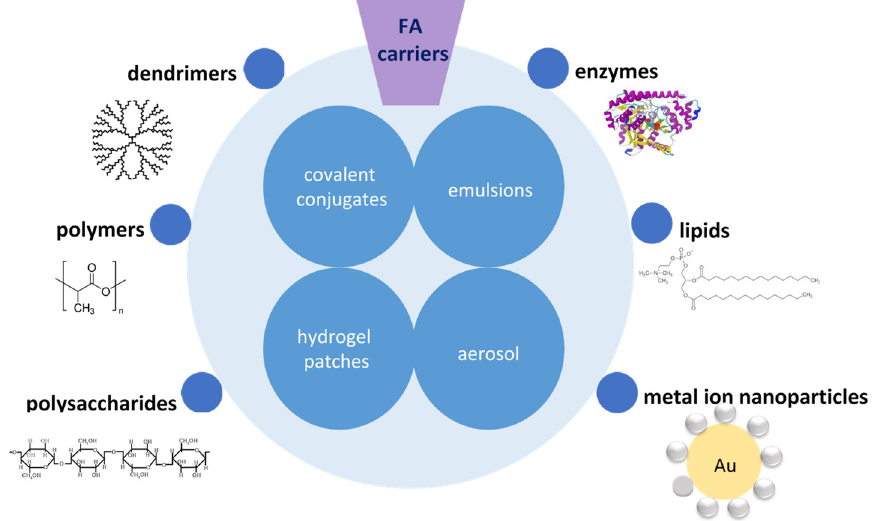
Figure 2. Novel formulations of ferulic acid (FA).